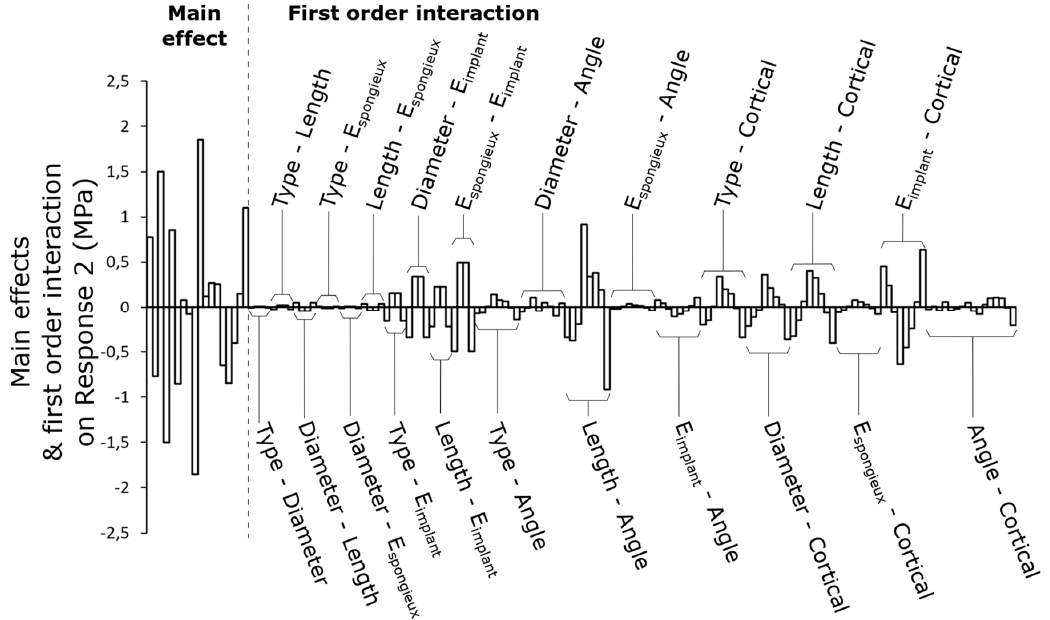
Figure 6. Main effects and first order interactions between parameters on Response 2. Figure 6. Main e ff ects and first order interactions between parameters on Response